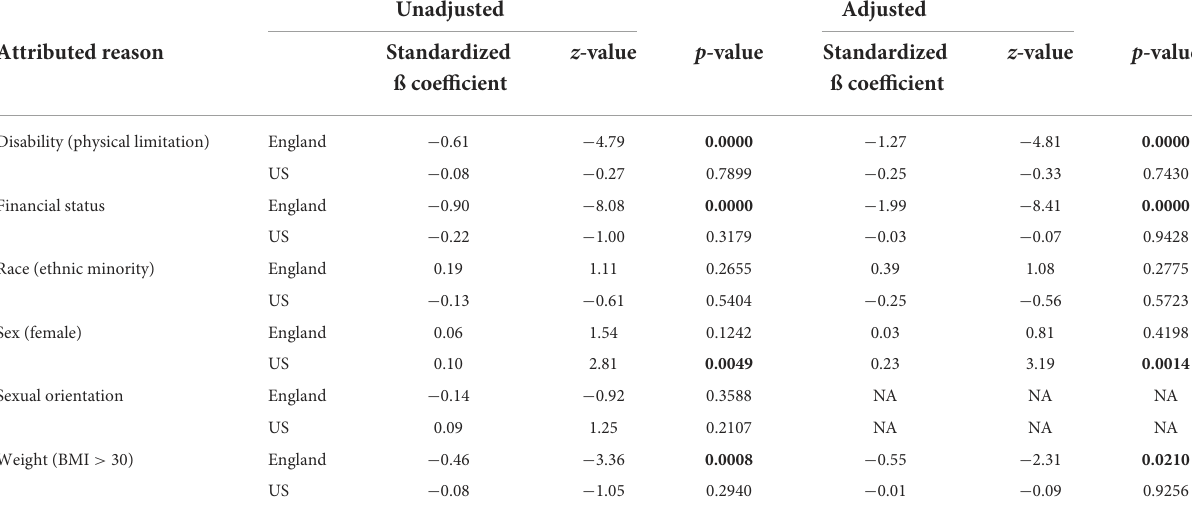
TABLE 4 Wealth gradient in perceived discrimination: logistic regression coefficients describing the association between wealth (USD) and perceived discrimination.